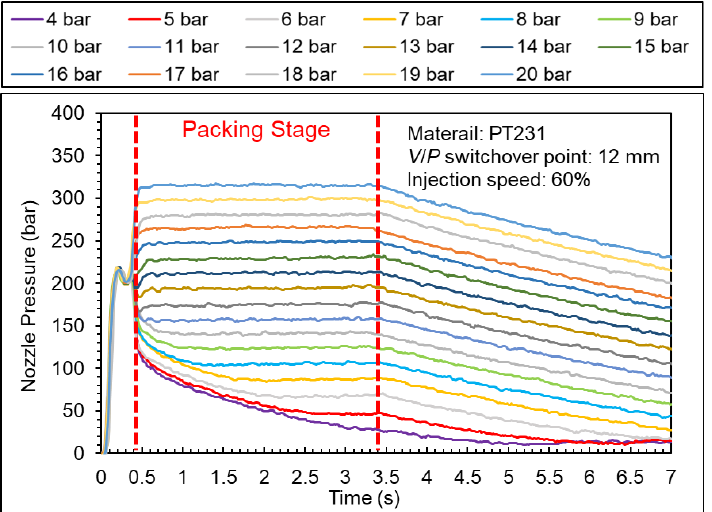
Figure A5. Nozzle pressure profiles of 6331 at different packing pressures.